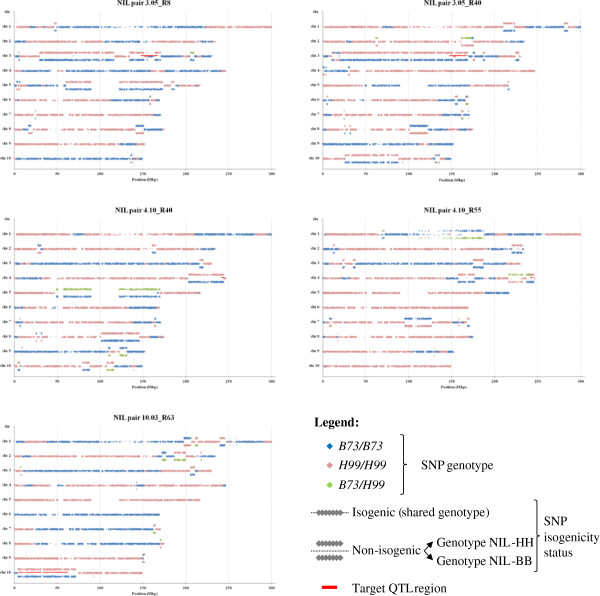
Genotypic structure and isogenicity of NIL pairs. Graphs synthesizing information both on the overall genotypic structure of NILs (i.e., position and size of recombination blocks, given by colors) and on genotype and position of non-isogenic regions (unaligned plotting lines). Each panel represent contrasting NILs within a pair. Genotypes at SNPs are color coded (B73/B73 = blue; H99/H99 = pink; B73/H99 = green). For each chromosome, non-isogenic regions are plotted as two separate lines above (SNP score in NIL-HH) and below (SNP score in NIL-BB) a shared line in the middle, where SNPs with the same genotype in both NILs (i.e., isogenic) are plotted. Red bars represent the QTL introgression regions.